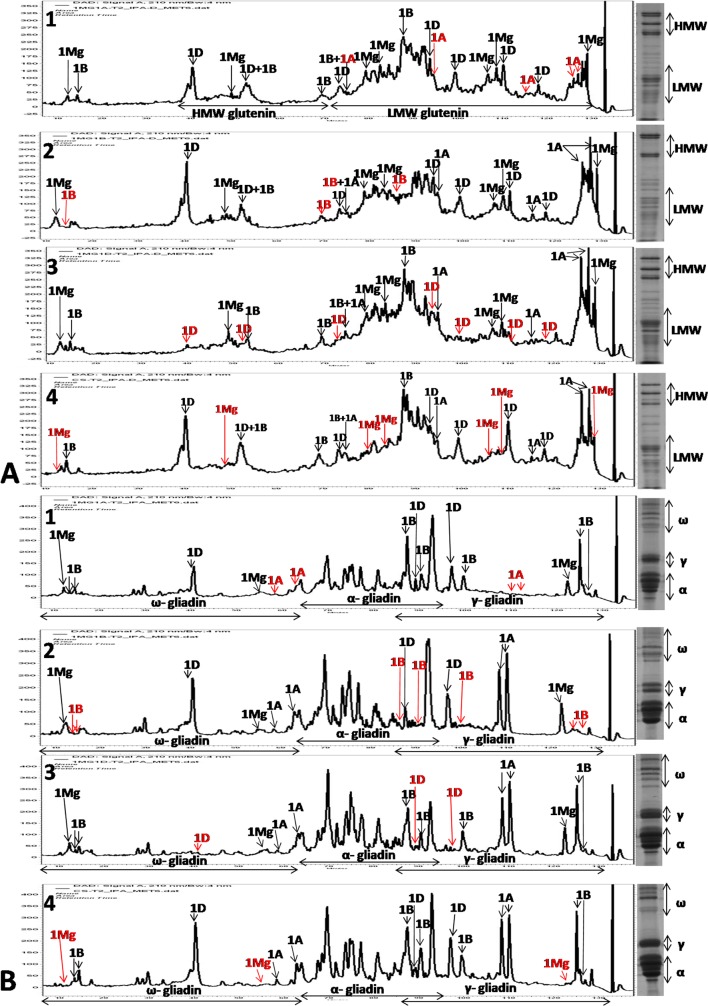
RP-HPLC profiles of DSLs in comparison to CS.A- glutenins, B- gliadins. 1- DSL1Mg(1A), 2- DSL1Mg(1B), 3- DSL1Mg(1D), 4-CS. Almost all the peaks were assigned to individual wheat or Ae. geniculata chromosomes.